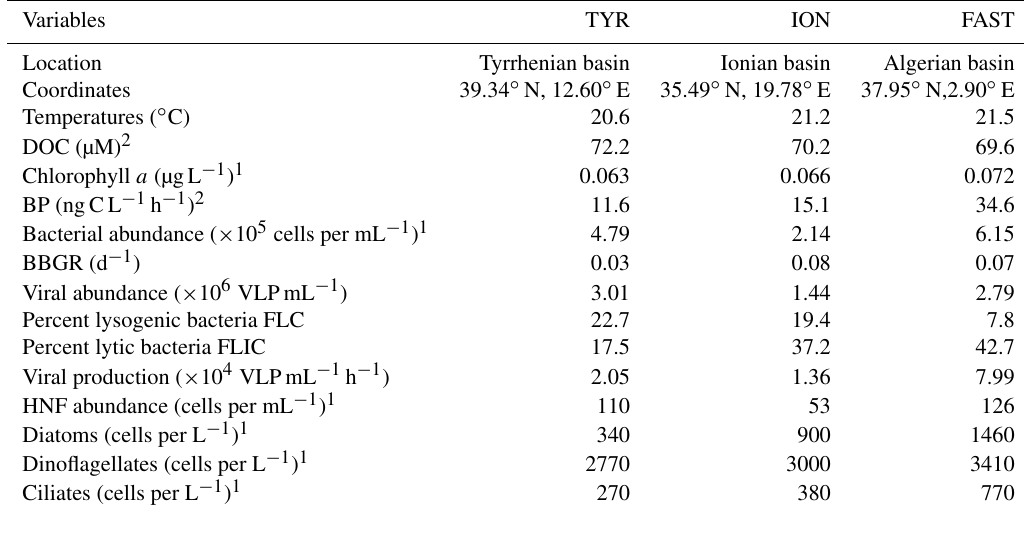
Table 1. Initial conditions (t12h) at the three stations sampled for the dust addition experiments. Other parameters are presented in more detail in Gazeau et al. (2021a,